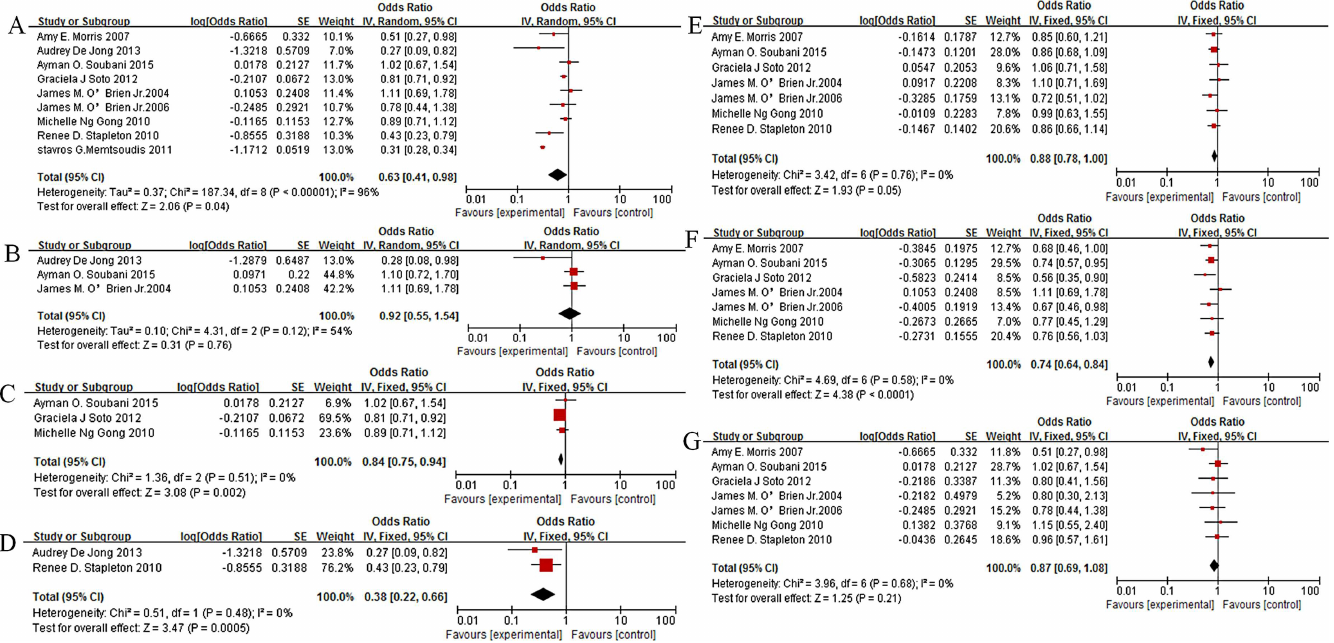
Fig 3. Association of obesity and mortality in ARDS/ALI patients. A:pooled result; B: 28days; C: 60days; D: 90days;E: overweightvs normal; F: obese vs normal; G: morbid obese vs normal.